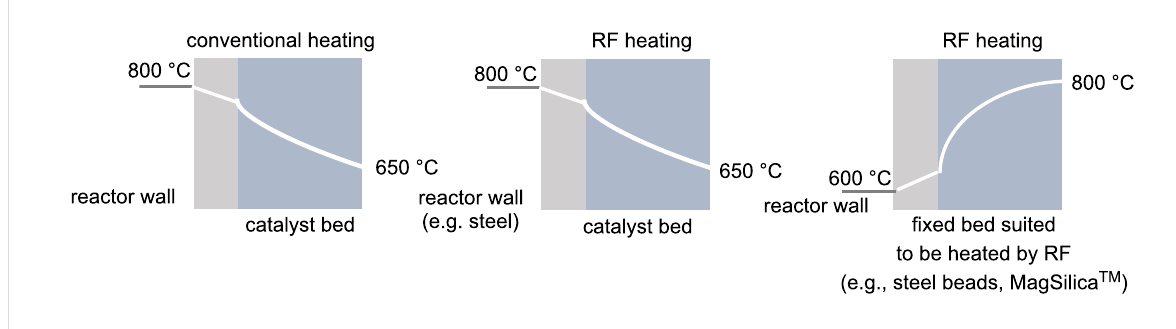
Figure 3: Temperature profiles of reactors heated conventionally and by RF heating (Figure 3 redrawn from